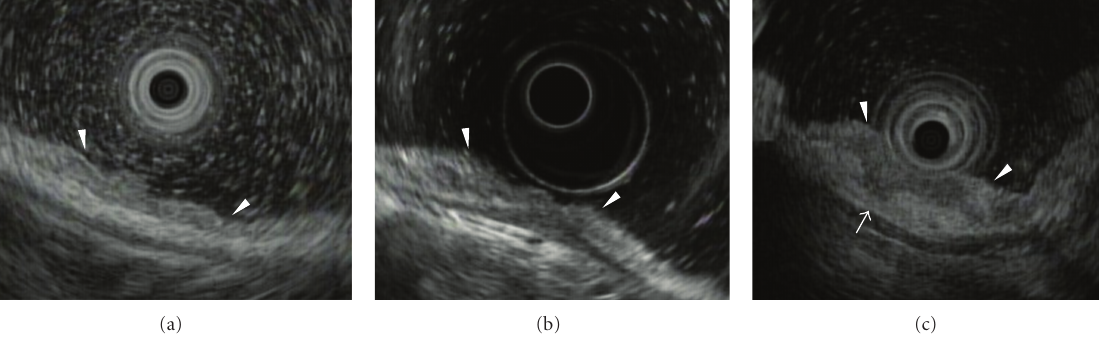
Figure 1: Endoscopic ultrasonography images of early gastric cancer. (a) EUS-M/SM1, type 0-IIc: there is no destruction in the first and second layers. The third layer looks normal. (b) EUS-M/SM1, type 0-IIc+III: the third layer shows smooth tapering and convergence. (c) EUS-SM2, type 0-IIa: a hypoechoic tumor shows the submucosal invasion. (white arrow).